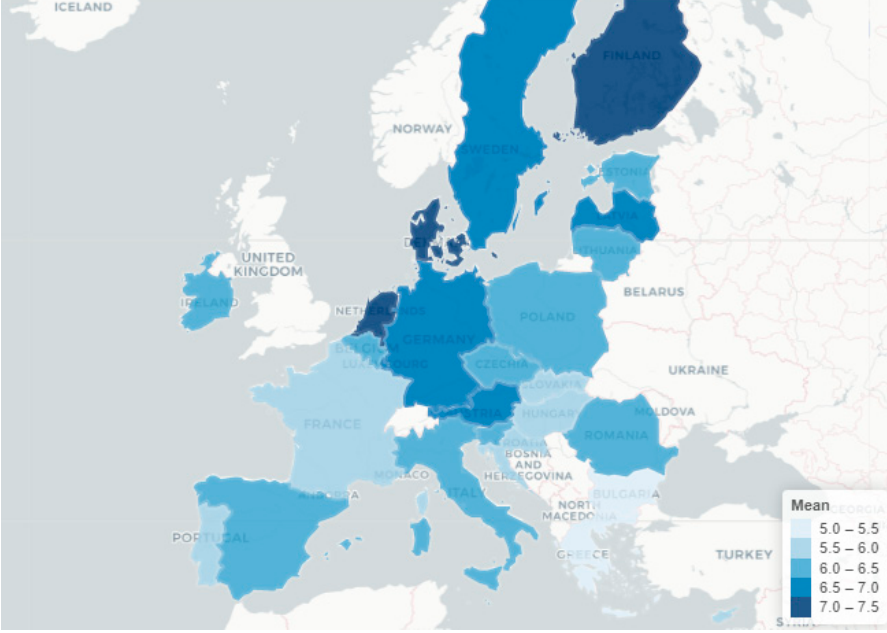
Figure 1. Life satisfaction in selected European countries during April/May 2020 (on a scale of 1–10).